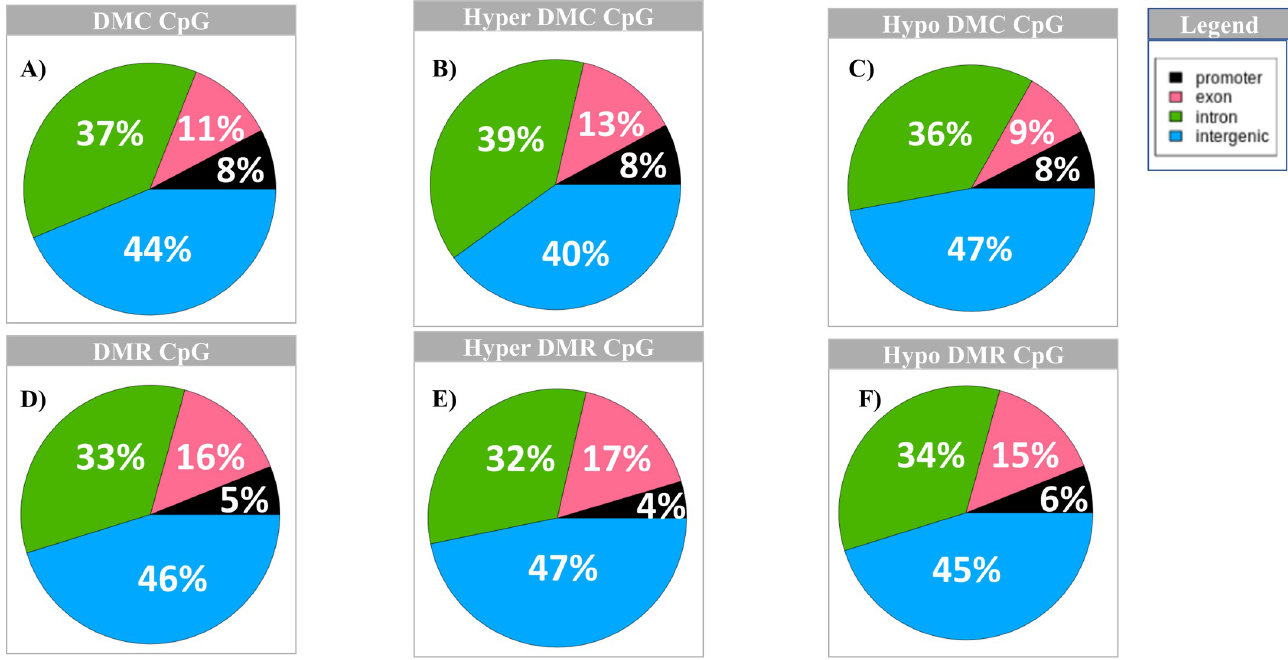
Fig 2. Distribution of total CpG DMC and DMR across the different genomic regions. A) Distribution of DMC CpG; B) Distribution of hyper DMC CpG; C) Distribution of hypo DMC CpG; D) Distribution of DMR CpG; E) Distribution of hyper DMR CpG; F) Distribution of hypo DMR CpG; Distribution of hypo DMR CpG. Legend: black = promoter region; pink = exon; green = intron and blue = intergenic regions.